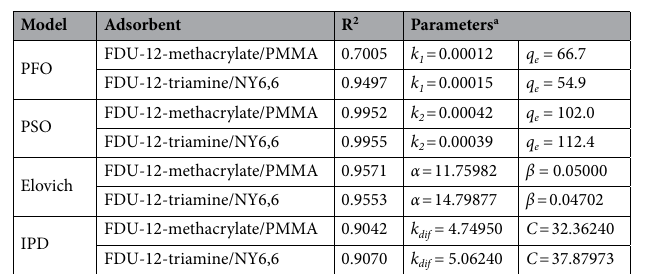
Table 1. Parameters obtained by kinetic models for the adsorption of Pb(II) onto the prepared adsorbents. a The units are as same as mentioned in the section “Adsorption kinetic studies”.